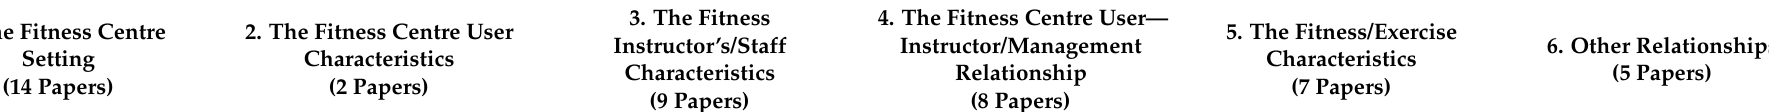
Table 4. Facilitators of exercising amongst adults with physical disabilities (AwPD) distributed across the six modified context factor categories. Numbers in parentheses in the coloured cells refer to the total number of different papers (references in the square brackets) informing each of the six